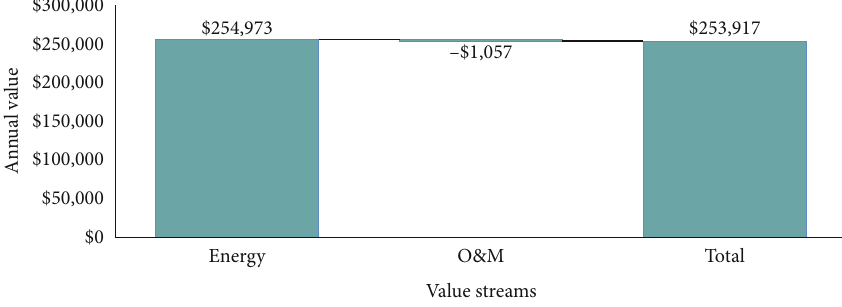
Figure 43: Categorized annual savings for a proposed system for South Sudan.